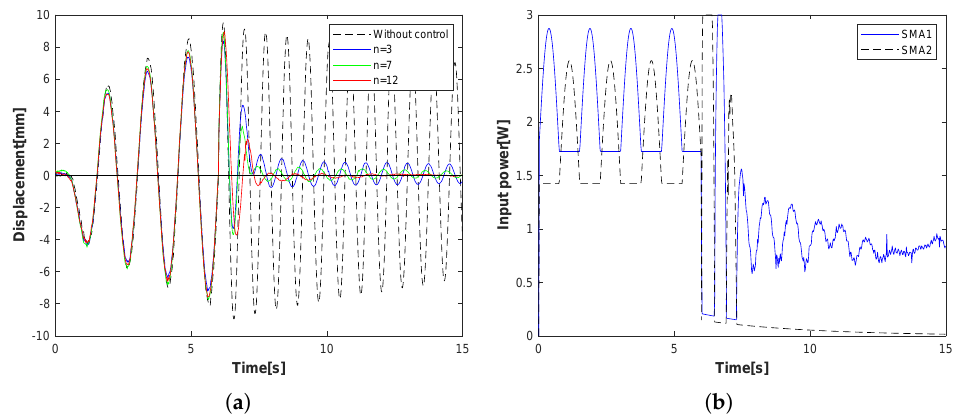
Figure 7. Experimental case 2: the tracking performance of n -times feedback loop. ( a ) Displacement of the flexible arm ( n = 3, 7, 12). ( b ) Input power of SMA actuator ( n = 12).